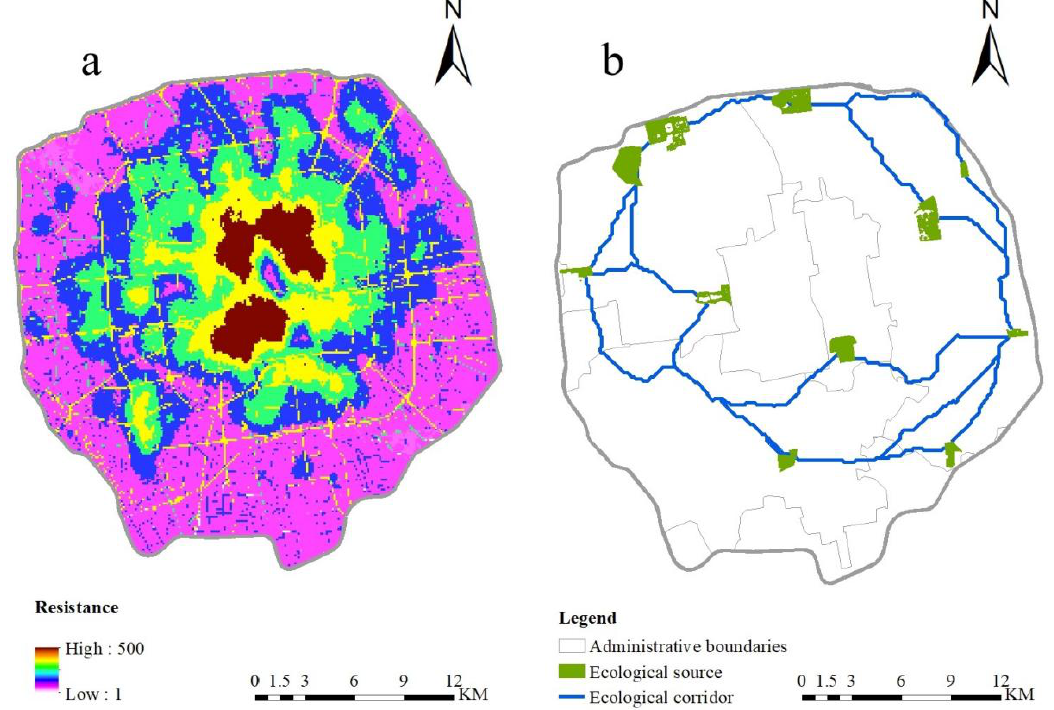
Figure 5. Two-dimensional EN. Note: a . 2D resistance surface; b . ecological corridor.